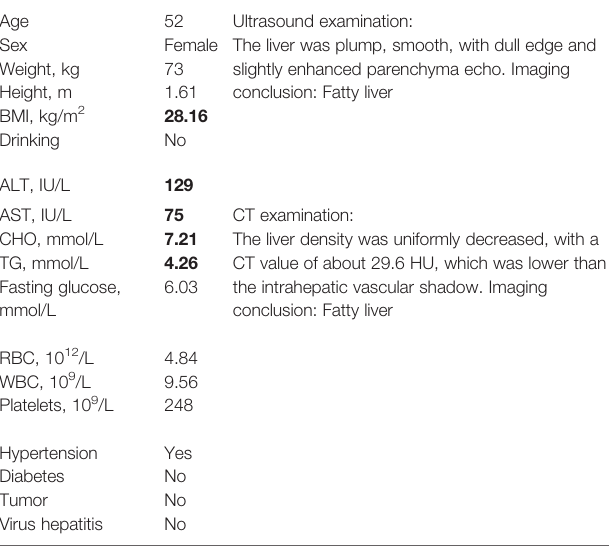
TABLE 3 | Clinical characteristics of a NASH patient.